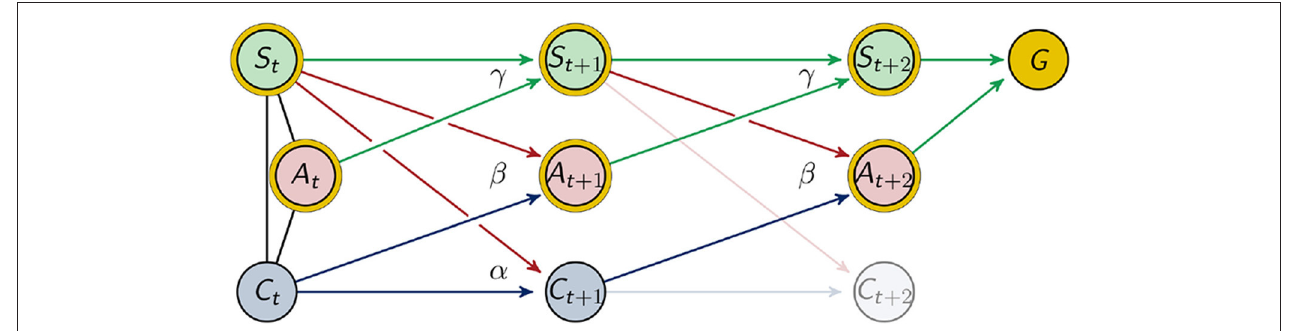
FIGURE 4 | Graphical representation of two